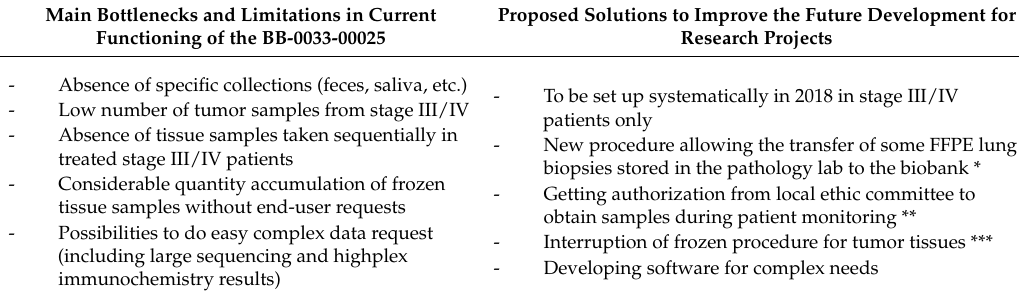
Table 1. Key actions and policy